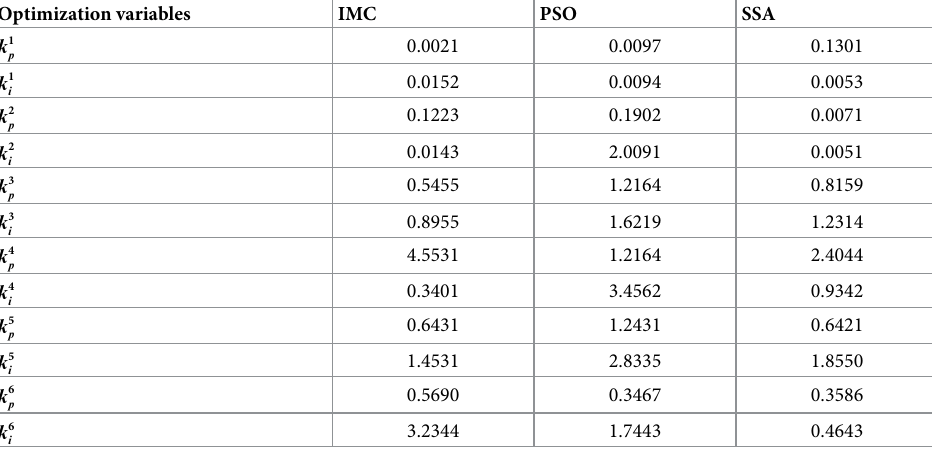
Table 2. Optimized PI regulator